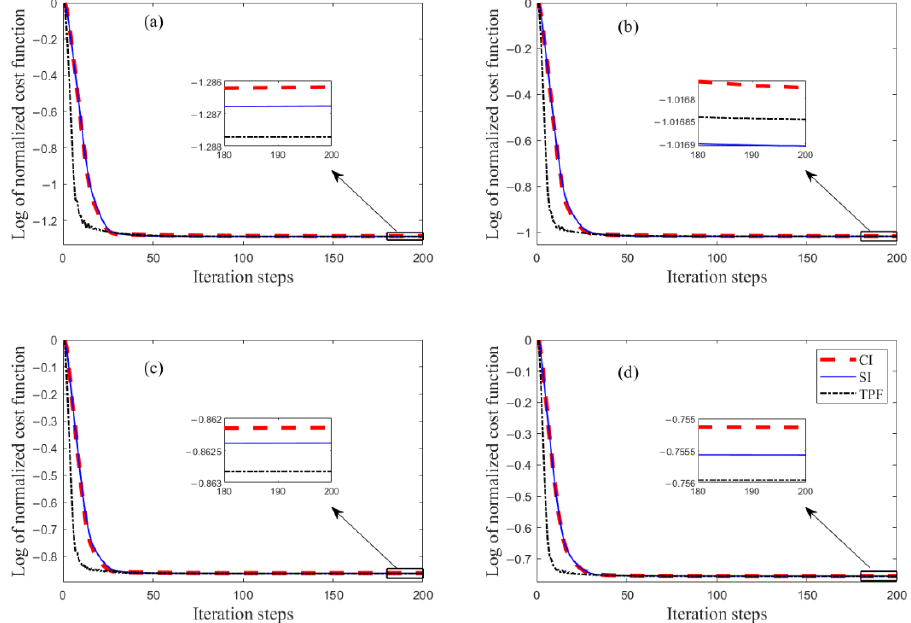
Figure 8. The descent process with iteration steps for the normalized cost function in log form of TE-5 ( a ), TE-6 ( b ), TE-7 ( c ) and TE-8 ( d ).